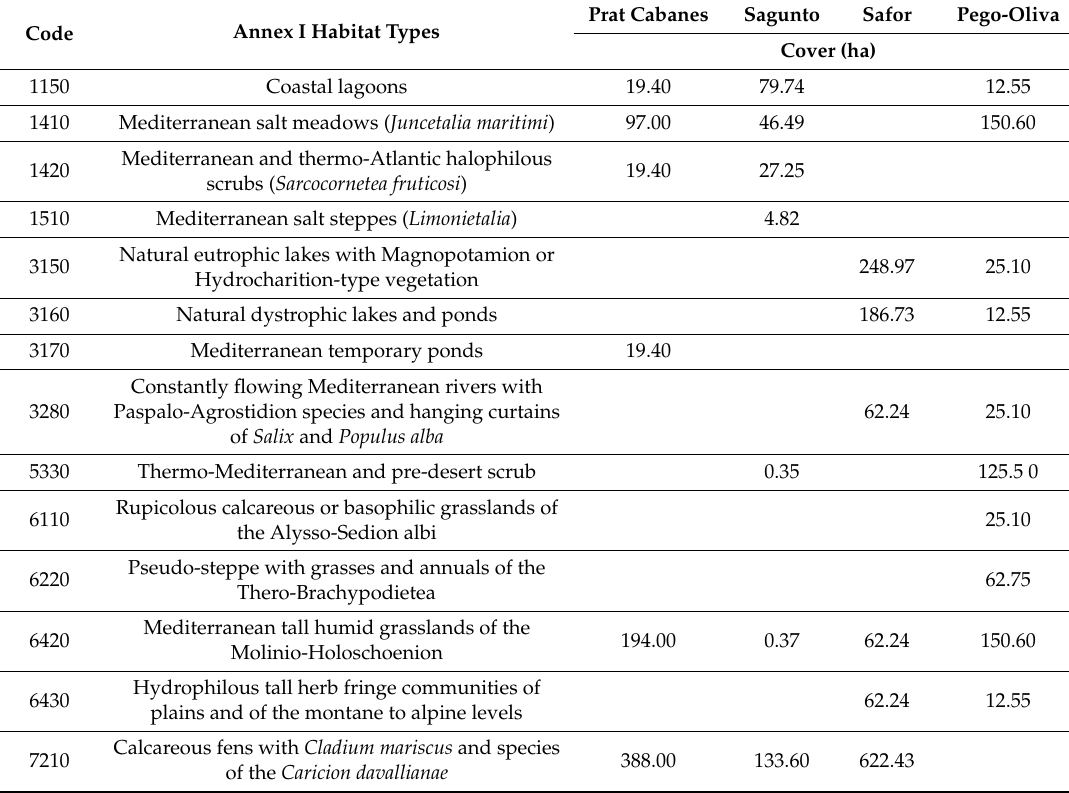
Table 2. Natura 2000 Habitat types present in the study areas according to the European Union (EU) Habitats Directive Annex I classification (source: https: // eunis.eea.europa.eu / index.jsp). Empty cell means the habitat is not present in that